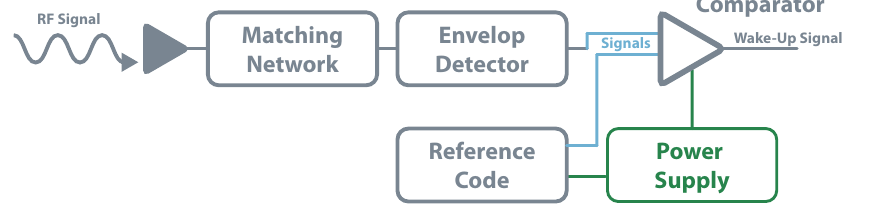
Figure 18. WUR—active architecture.